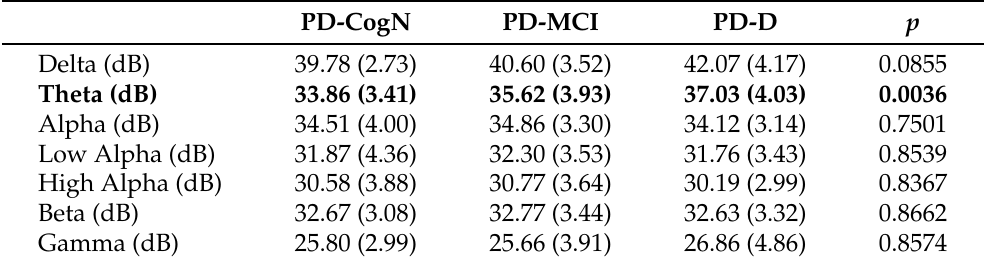
Table 2. Mean (standard deviation) global absolute power in subgroups. Bold indicates statistically significant differences.